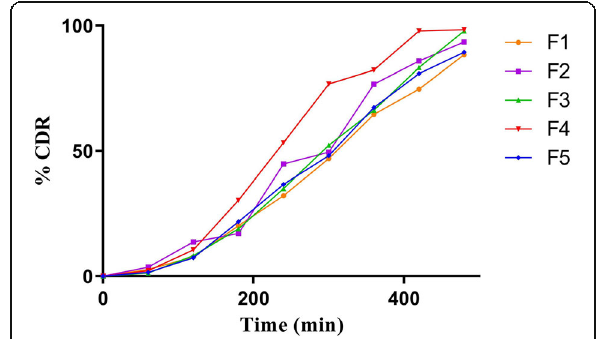
Fig. 7 Zero-order release kinetics of CPT herbal formulation